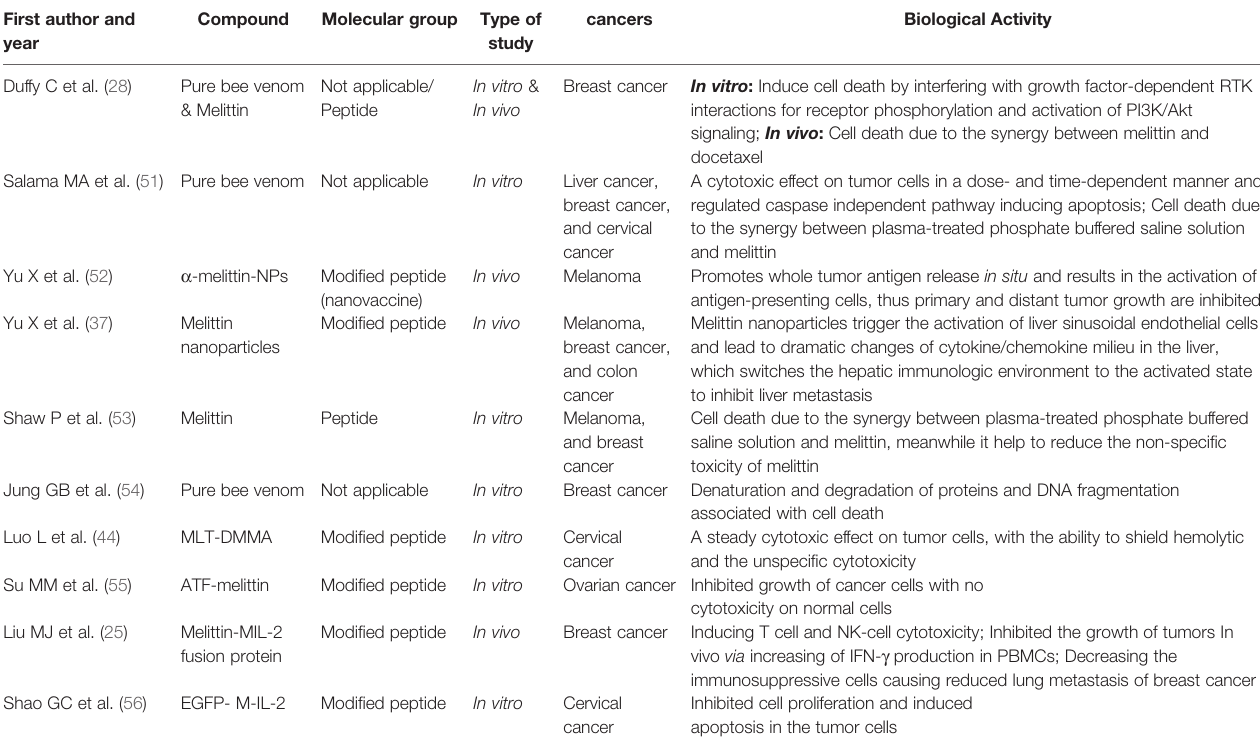
TABLE 1 | Selected recent publications about antitumor effects of bee venom and its components or